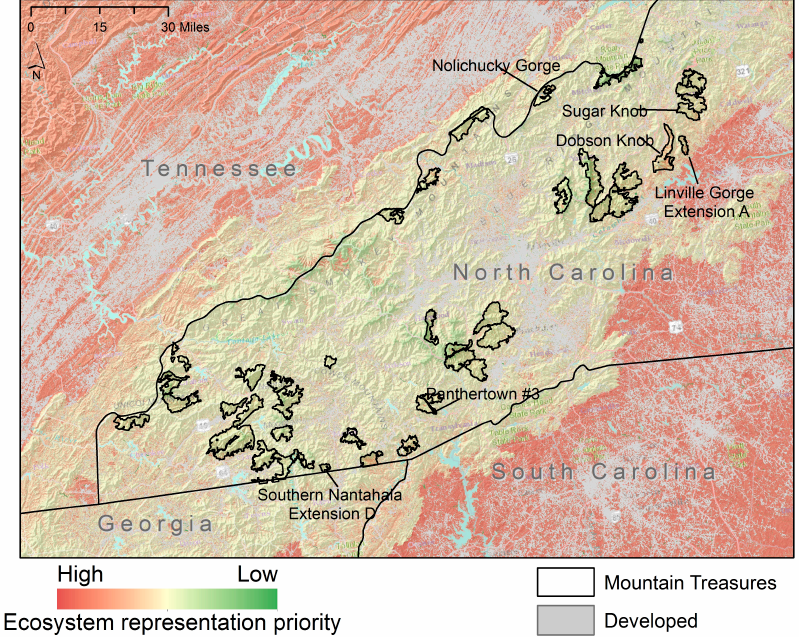
Figure 5. Map of the ecosystem representation priorities in the Southern Appalachian Mountains